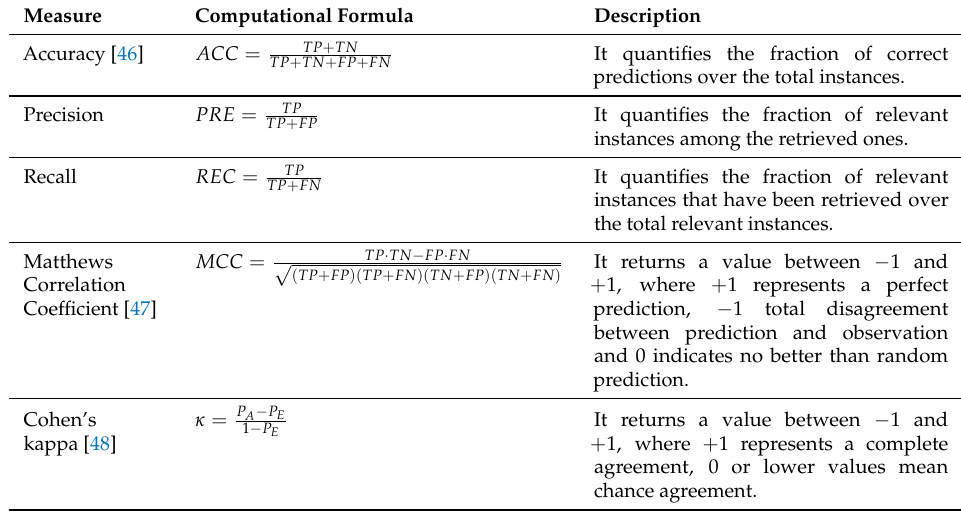
Table 1. Evaluation measures for the binary classification problem: TP—true positives (the total number of active compounds that are predicted correctly), TN—true negatives (the total number of inactive compounds that are predicted correctly), FP—false positives (the total number of these compounds that have no interaction with the receptor but are predicted as active), FN—false negatives (the total number of these compounds that are active but are predicted as inactive), P A —an observed level of agreement, P E —an expected level of